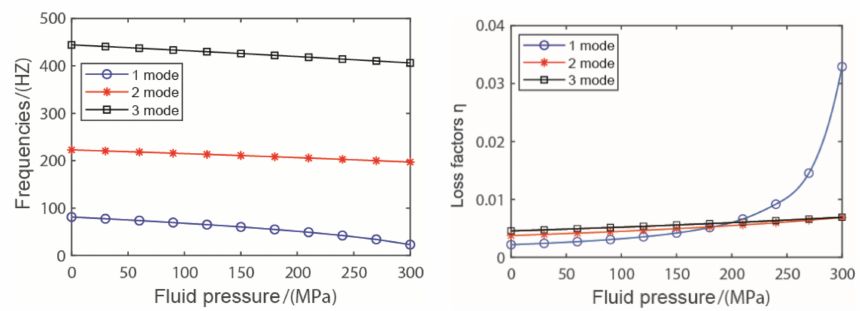
Figure 6. The influence of fluid pressure.